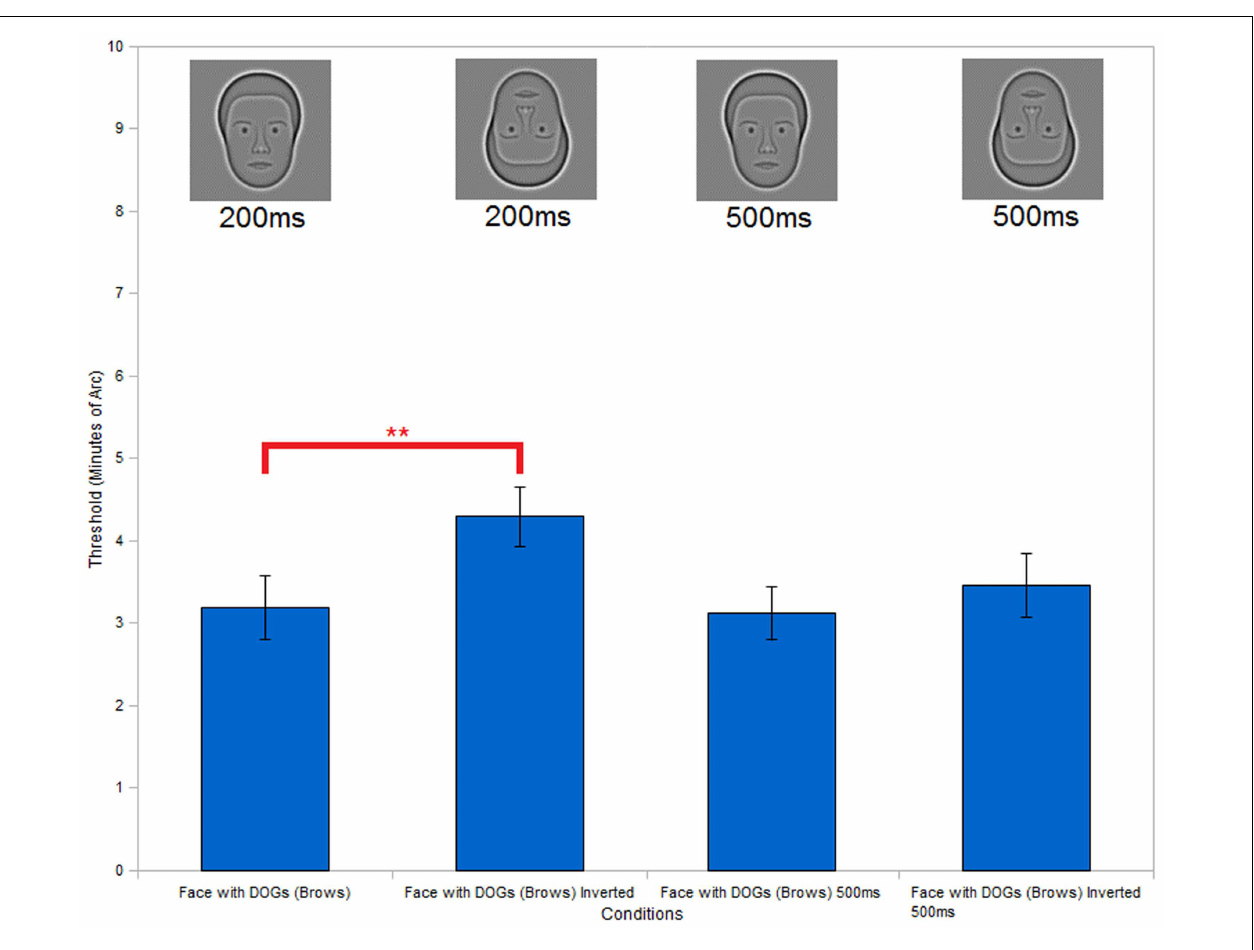
exposure duration of 200ms. Repetition of the inversion test with the same stimuli and increased exposure duration (500ms) shows no significant differences between the upright and inverted conditions. (** P <